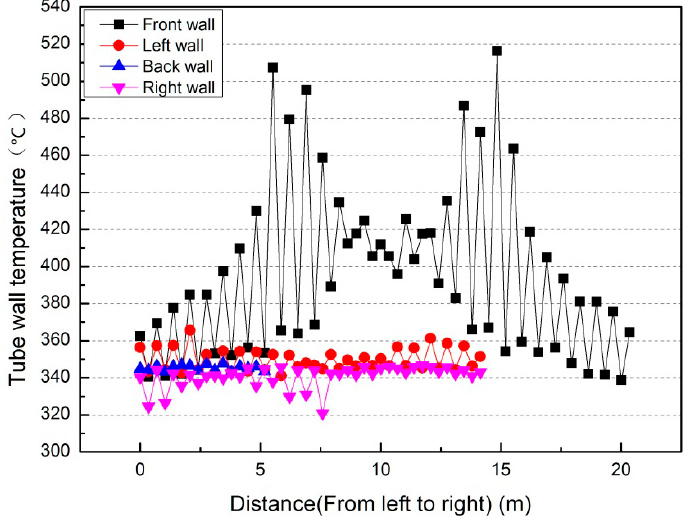
Figure 4. Tube temperature distribution along the vertical water-cooled wall under the minimum load.